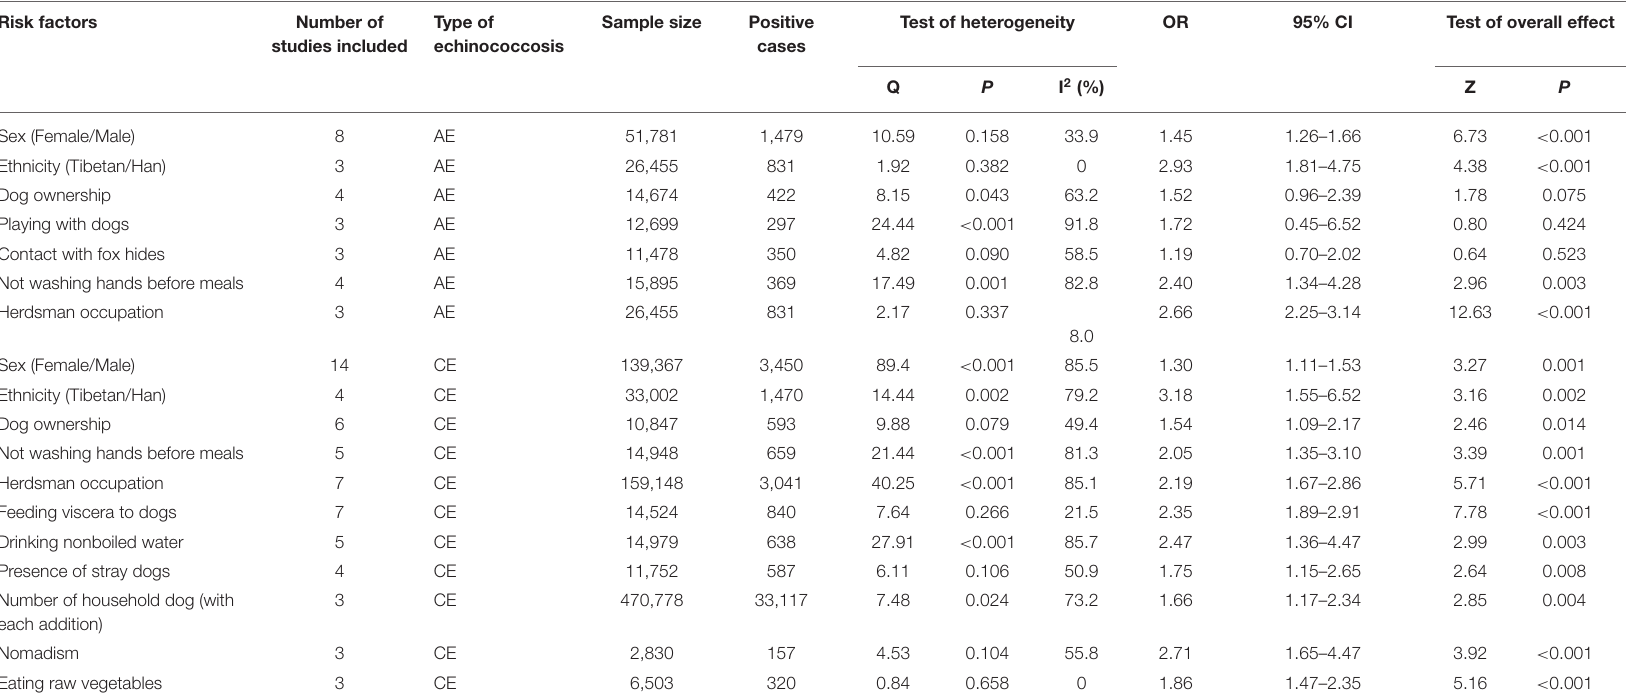
TABLE 2 | Result of echinococcosis risk factors